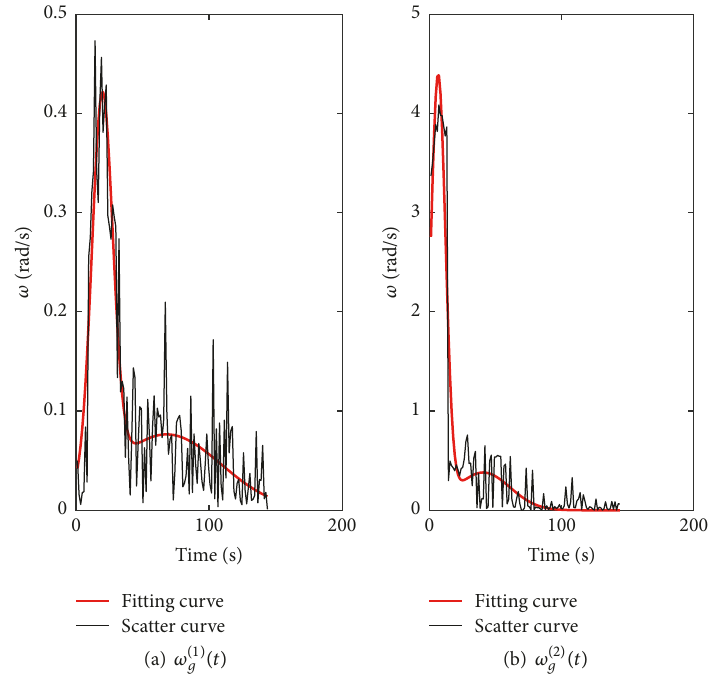
Figure 5: Fitting of parameters 𝜔 (1) 𝑔 (𝑡),𝜔 (2) 𝑔 (𝑡) for the 8244 Orion accelerogram seismic wave.